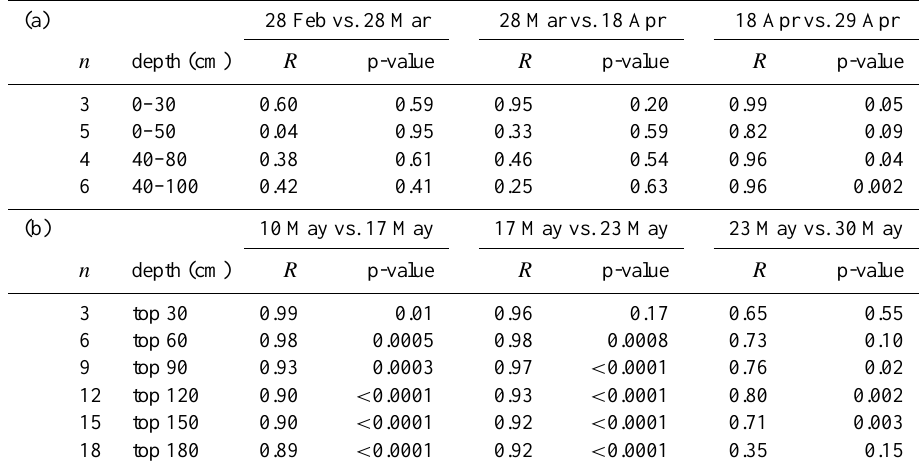
Table 3. Pearson’s R correlation for rBC concentrations in various regions of snow pit profiles; assuming same snowpack for the (a) accu- mulation period (buried regions) and (b) ablation